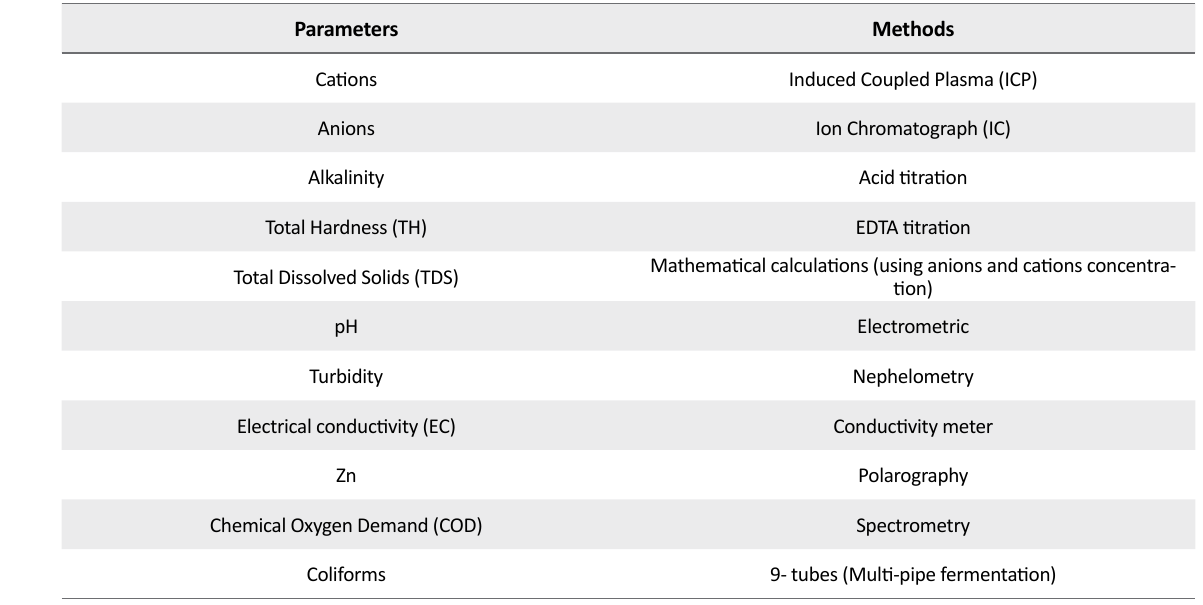
Table 1. Sampling analysis techniques